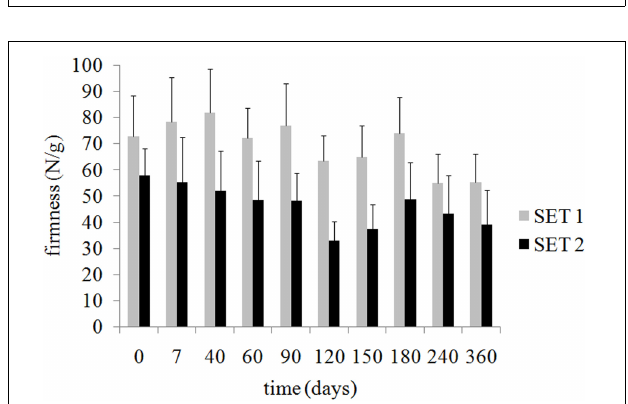
FIGURE 1 | Changes in pH of Bella di Cerignola Spanish-style olives packaged in PTE bags (olive/brine ratio, 8/1): SET1 (bio-preserved), SET2 (control). Means and standard deviations were obtained from measurements made in duplicate packages from 2 different experiments ( n = 4).